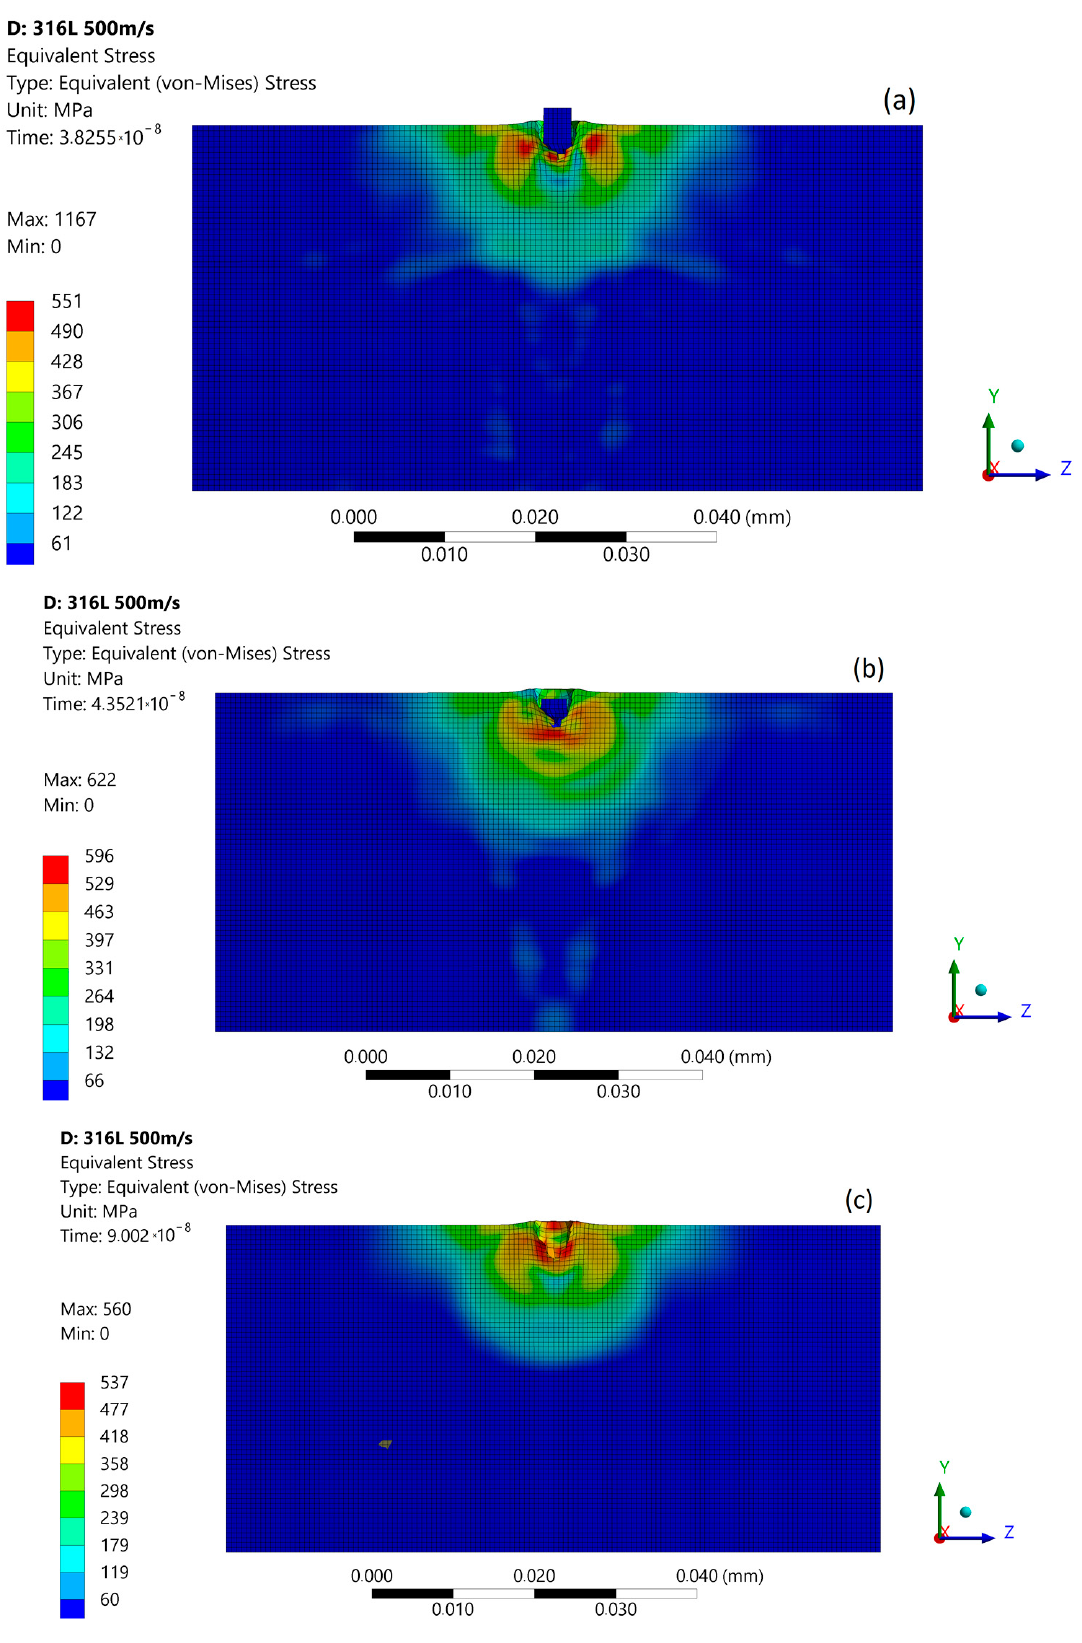
Figure 13. Von Mises stress distribution during subsequent micro-jet impact at 200 m/s: ( a ) initial stage of the impact; ( b ) stage during the impact; ( c ) residual stress after the